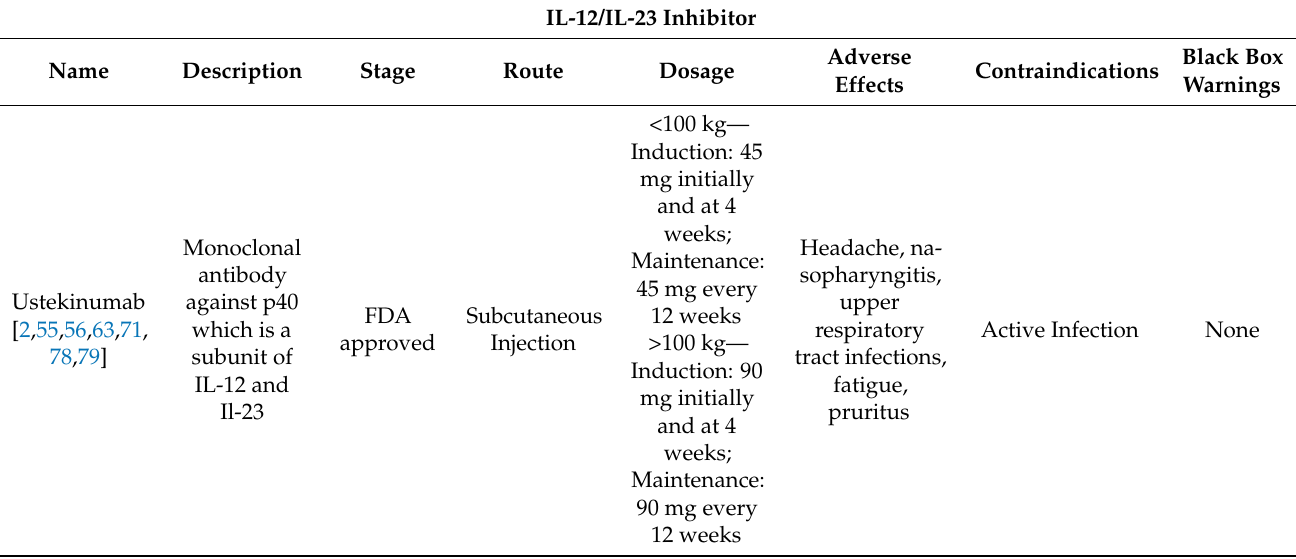
Table 3. Summary of IL-12/23